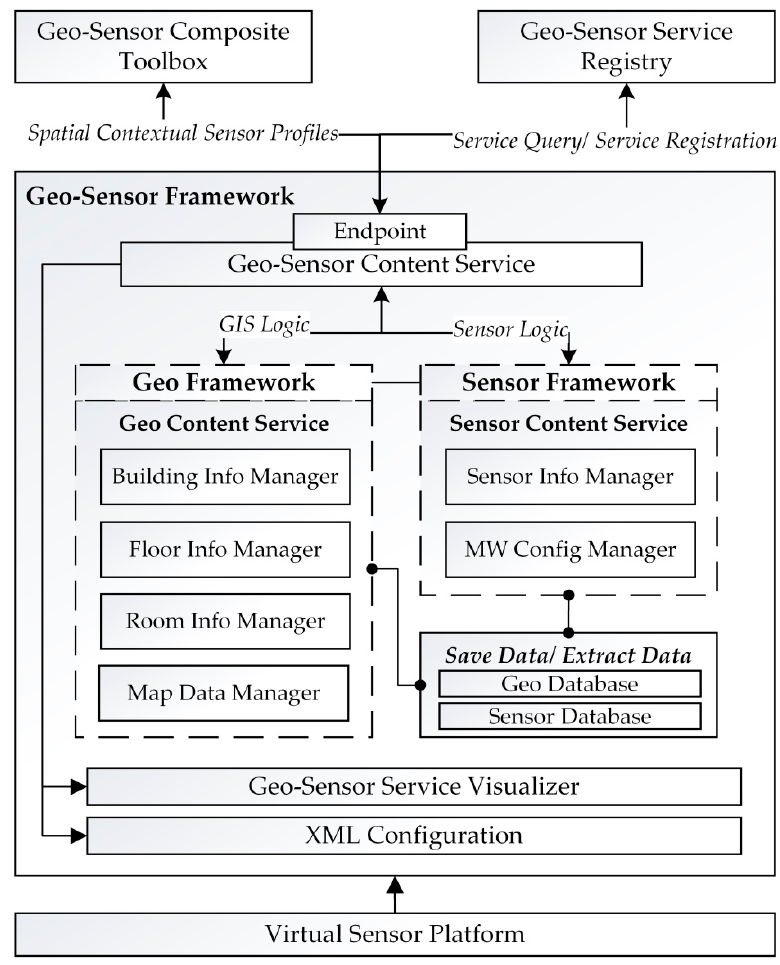
Figure 3. Proposed geo-sensor framework configuration.